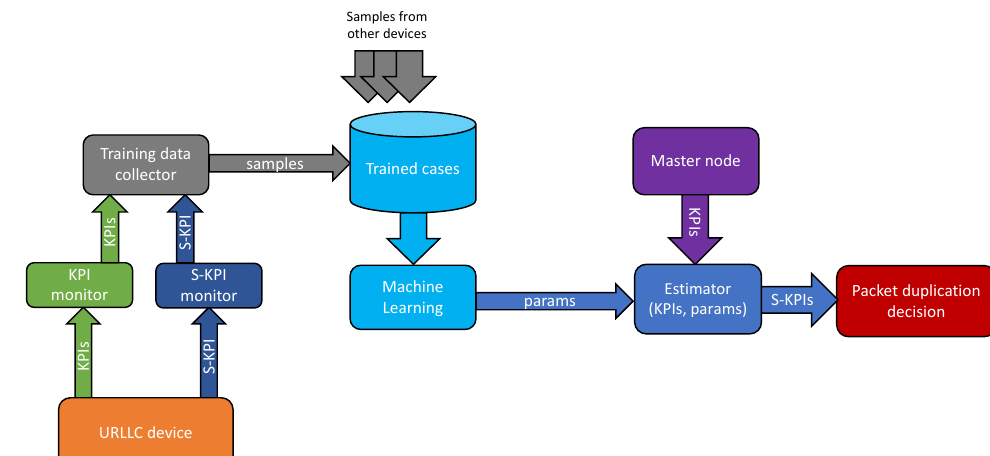
Figure 2. Block diagram of the